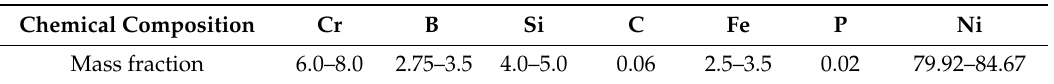
Table 2. Chemical composition of BNi-2